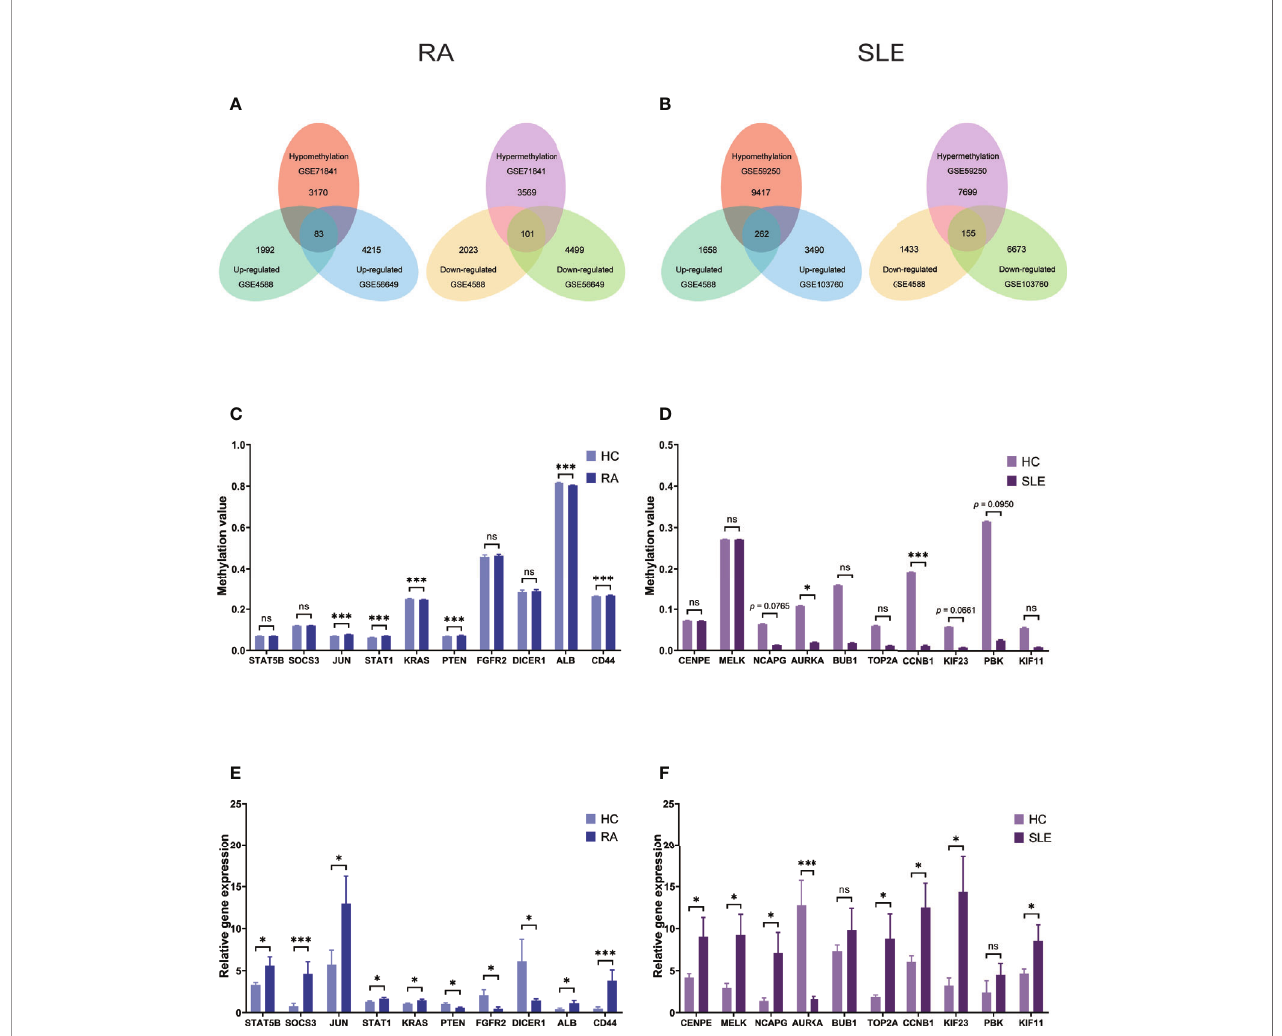
FIGURE 5 | Identi fi cation of aberrantly methylatedDEGs of CD4 + T cells in RA andSLE. (A) Aberrantlymethylated DEGs ofCD4 + T cells inRA and (B) SLE; (C) Methylation level of top10 hub genes inCD4 + T cells fromRA; (D) and SLE; (E) Expression levels of top10 hub genes inCD4 + T cells fromRA and (F) SLE. ns, not signi fi cant. *p < 0.05; ***p <